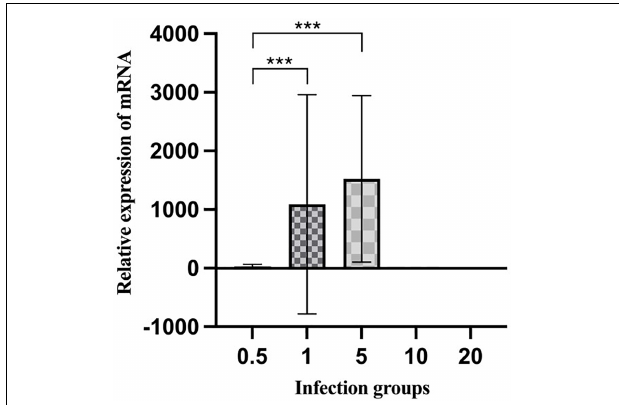
FIGURE 4 | Expression levels of mRNA measured by qPCR. The total RNAs were extracted from the BHK-21 cells infected with different groups of rVSVmc-p and used in reverse transcription to generate cDNA. All data points were derived from at least four biological replicates, with the standard deviation shown by the error bars. p -values were calculated using a two-tailed t -test; *** indicates p < 0.01.